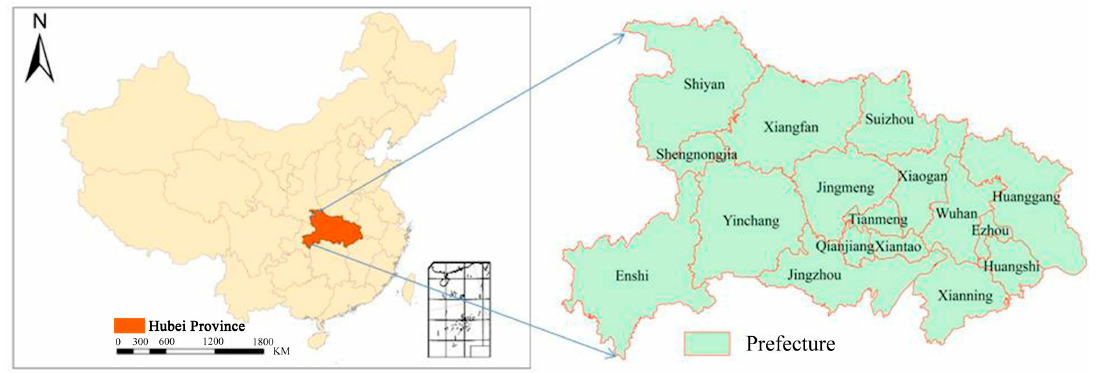
Figure 1. Location of the study